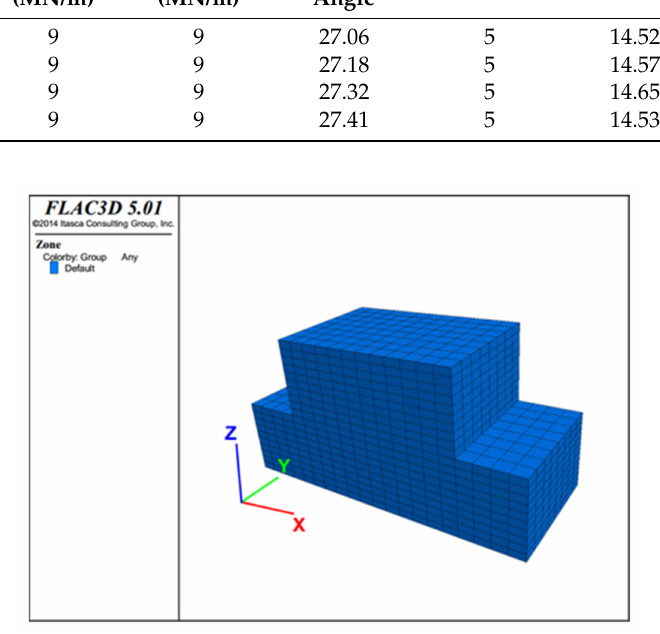
Figure 9. Direct shear test model